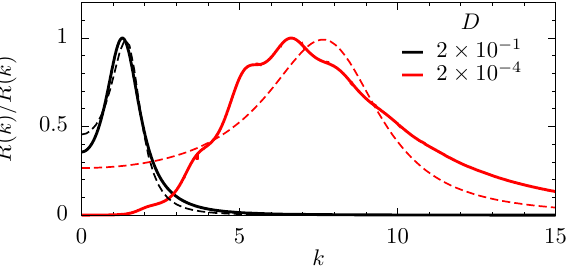
Figure 6. Comparison of ˜ R ( k ) with the harmonic response ˜ R H ( k ) , both normalized to their maximal values. R ( k ) of our model, given by Eq. (11) (solid lines) and harmonic response ˜ lines), where the values of k 0 and ζ were obtained by fitting Eq. (12) to ˜ R ( k ) . In all cases, q two different values of D shown in the legend were considered. Notice that for D be described by the harmonic approximation. For D the harmonic approximation fails. In fact, the dominant mode observed in the simulations is not given by the absolute maximum, but by the small hump at k